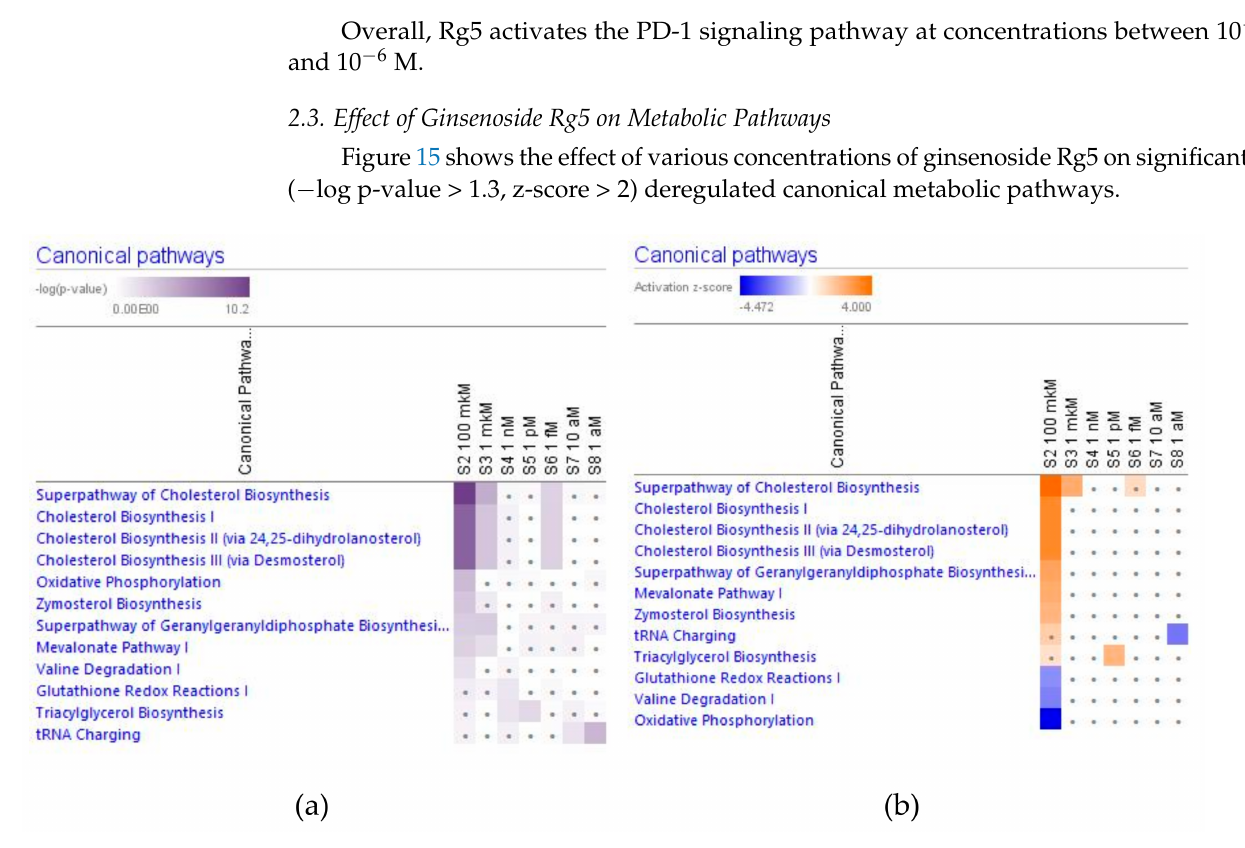
Figure 15. Effect of Rg5 at concentrations of 1 aM, 10 aM, 1 fM, 1 pM, 1 nM, 1 µ M and 100 µ M) on significantly deregulated metabolic signaling pathways. ( a ) The brown color shows the predicted activation, blue color—predicted inhibition of signaling pathway; the symbol shows that the activation z-score was <2. ( b ) the symbol shows that the − log p − value was